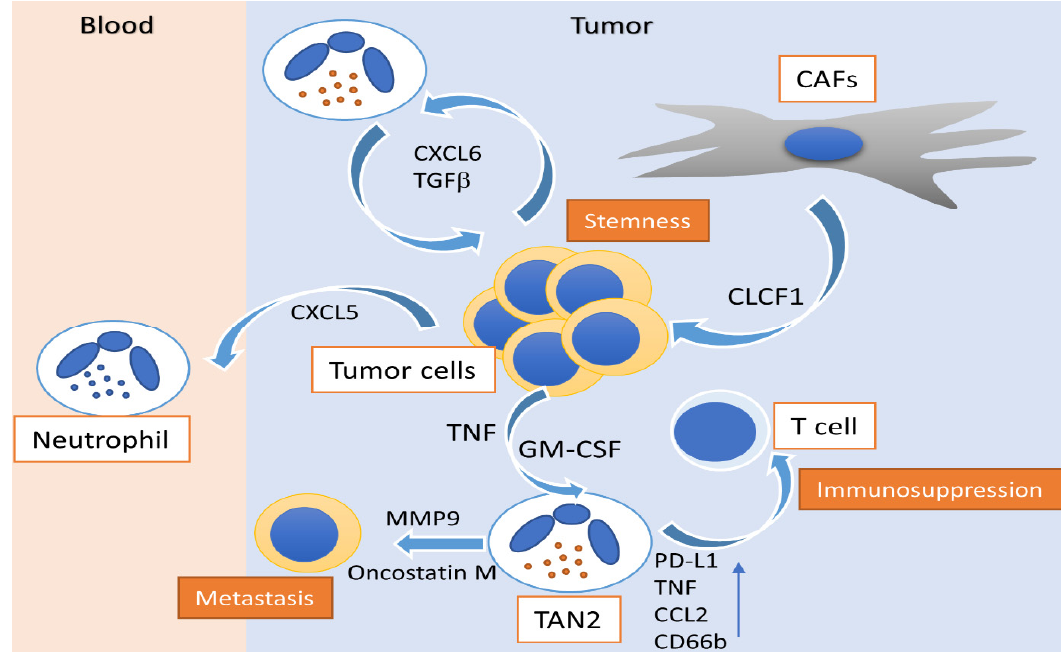
Figure 1. Activity of polarized N2 neutrophils in hepatocellular carcinoma. Peritumoral GM-CSF and CAFs modulate N2 neutrophils to an immunosuppressive profile, enhancing CD66b, PD-L1, TNF and CCL2 expression, alongside their capacity to suppress T cells. CAF-released CLCF1 drives the N2 polarization of TANs, induces CXCL6 and TGF- β production by tumor cells and promotes cancer stemness. N2 neutrophil-associated MMP-9 and oncostatin-M release promotes tumor neovascularization and enhances the metastatic potential of HCC. HCC: hepatocellular carcinoma; TAN: tumor-associated neutrophil; GM-CSF: granulocyte-macrophage colony-stimulating factor; TGF β : tumor growth factor- β ; TNF: tumor necrosis factor; PD-L1: programmed death-ligand 1; CXCL: C-X-C motif chemokine ligand; CCL2: C–C motif chemokine ligand 2; MMP-9: matrix metallopeptidase-9; CD66b: cluster of differentiation 66b; CAF: cancer-associated fibroblast; CLCF: cardiotrophin like cytokine factor.